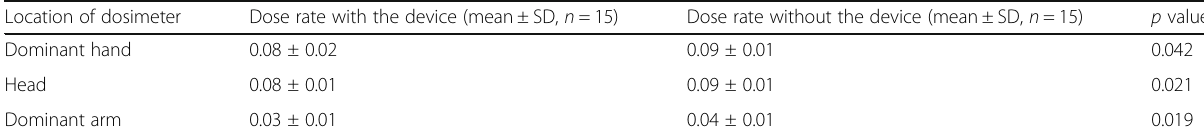
Table 3 Radiation dose rate (mSv/hour) for the assistant with and without the passive robotic device Location of dosimeter